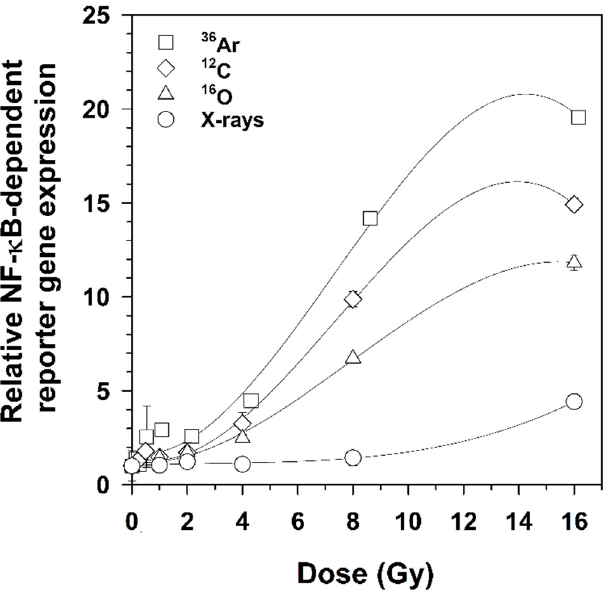
Figure 2. Activation of NF- κ B-dependent DD-tdTomato expression. Cells were fixed 18 h after exposure to 36 Ar (LET 272 keV/µm), 12 C (LET 73 keV/µm), 16 O (LET 51 keV/µm) ions, or X-rays. DD-tdTomato fluorescence intensity of the cells was measured by flow cytometry. The percentage of DD-tdTomato(+) cells in irradiated cell populations was normalized to that percentage in the mock-irradiated samples (0 Gy) (Mean ± SD, n = 2). Where the error bars are not visible, they are smaller than the symbol. Table 1. Description of radiation qualities based on energy and linear energy transfer (LET), and dose and average hits per cell nucleus that are required for doubling of NF- κ B-dependent reporter gene expression above background. Radiation